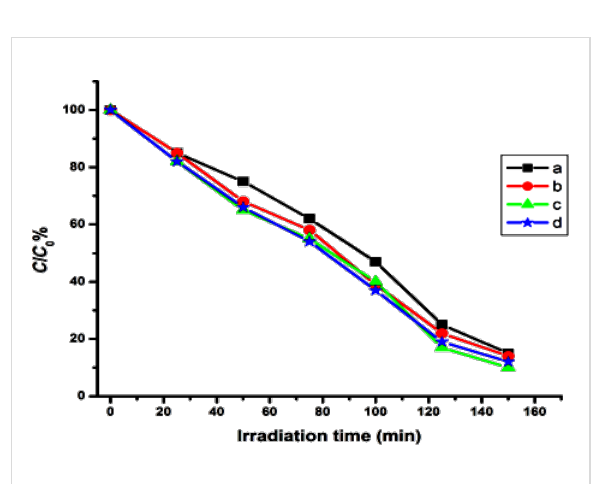
Figure 7: Degradation of RhB by Ta 2 O 5 nanoparticles synthesized from (a) Ta(O n -Bu) 4 , (b) Ta(O n -Bu) 4 (OOCCH 2 Cl), (c) Ta(O n - Bu) 4 (OOCCHCl 2 ) and (d) Ta(O n -Bu) 4 (OOCCCl 3 ).